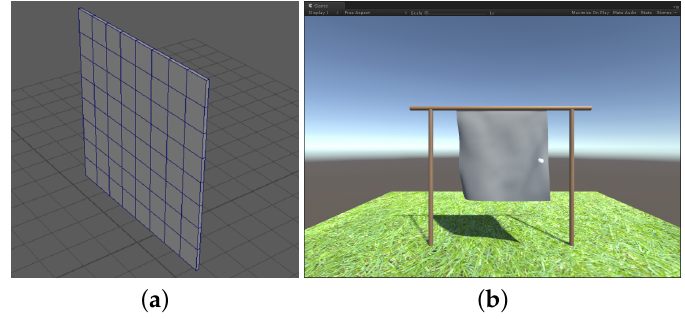
Figure 11. ( a ) Cloth model created using Maya software and ( b ) Cloth interaction